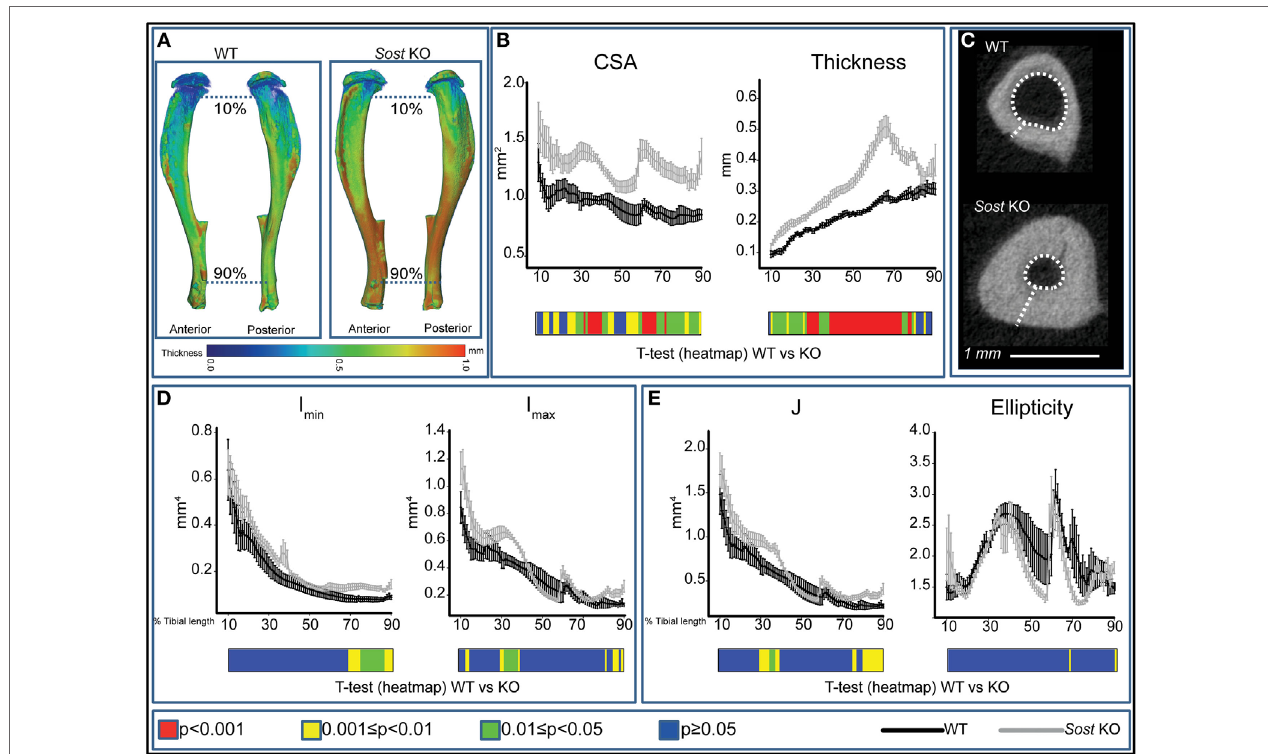
FigUre 1 | Modification in cortical bone phenotype in Sost knockout (KO) (gray) mice. (a) Representative 3D Micro-CT color-coded images of tibial cortical bone thickness. (B) Bone cross-sectional area (CSA) and mean cortical thickness between 10 and 90% of total tibial length. (c) Gross macroscopic comparison of microCT images of cortical tibia at the tibiofibular junction for both groups demonstrating a significantly thickened tibial cortex and reduced medullary cavity in Sost KO compared to wild-type (WT) mice. (D) Minimum and maximum second moments of area (I min and I max respectively) and (e) ellipticity and J (resistance to torsion) between 10 and 90% of total tibial length of WT and Sost KO mice. Graphical heat map (B,D,e) at the bottom of each graph summarizes statistical differences at specific matched locations along the tibial length, representative of overall effect of Sost deficiency: red p < 0.001, yellow 0.001 ≤ p < 0.01, green 0.01 ≤ p < 0.05, and blue p ≥ 0.05. Two-sample t -test was used to compare means between WT and Sost KO mice. Line graphs represent means ± SEM. Group sizes were n = 6 for WT and Sost KO